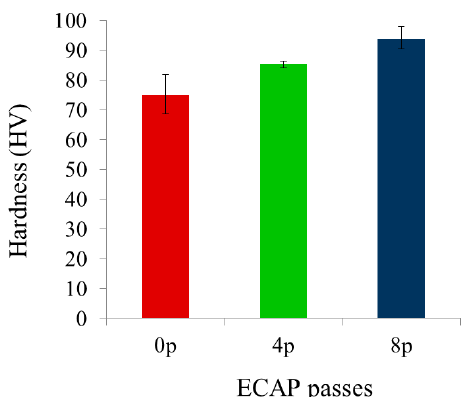
Figure 9. Influence of the ECAP passes on the microhardness of SiC p /Al-Si composites. The 0p-ECAP sample corresponds to the PM composite without ECAP processing.